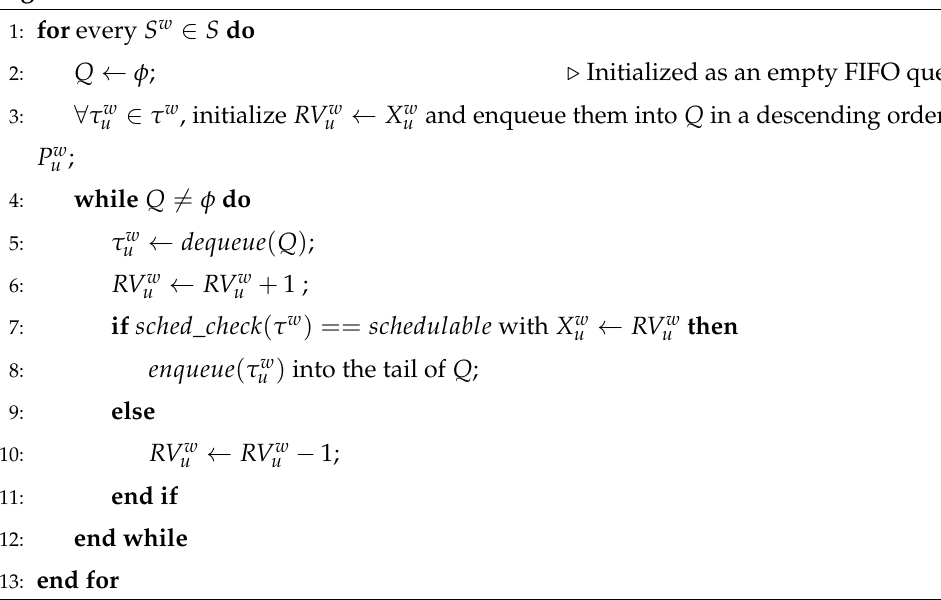
Algorithm 1 Calculation of reservation